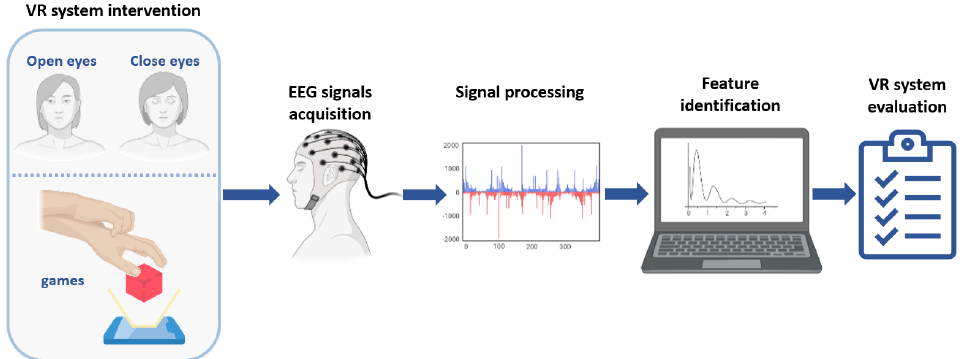
Figure 1. The general methodology was followed for the viability study of the VR intervention program in people diagnosed with